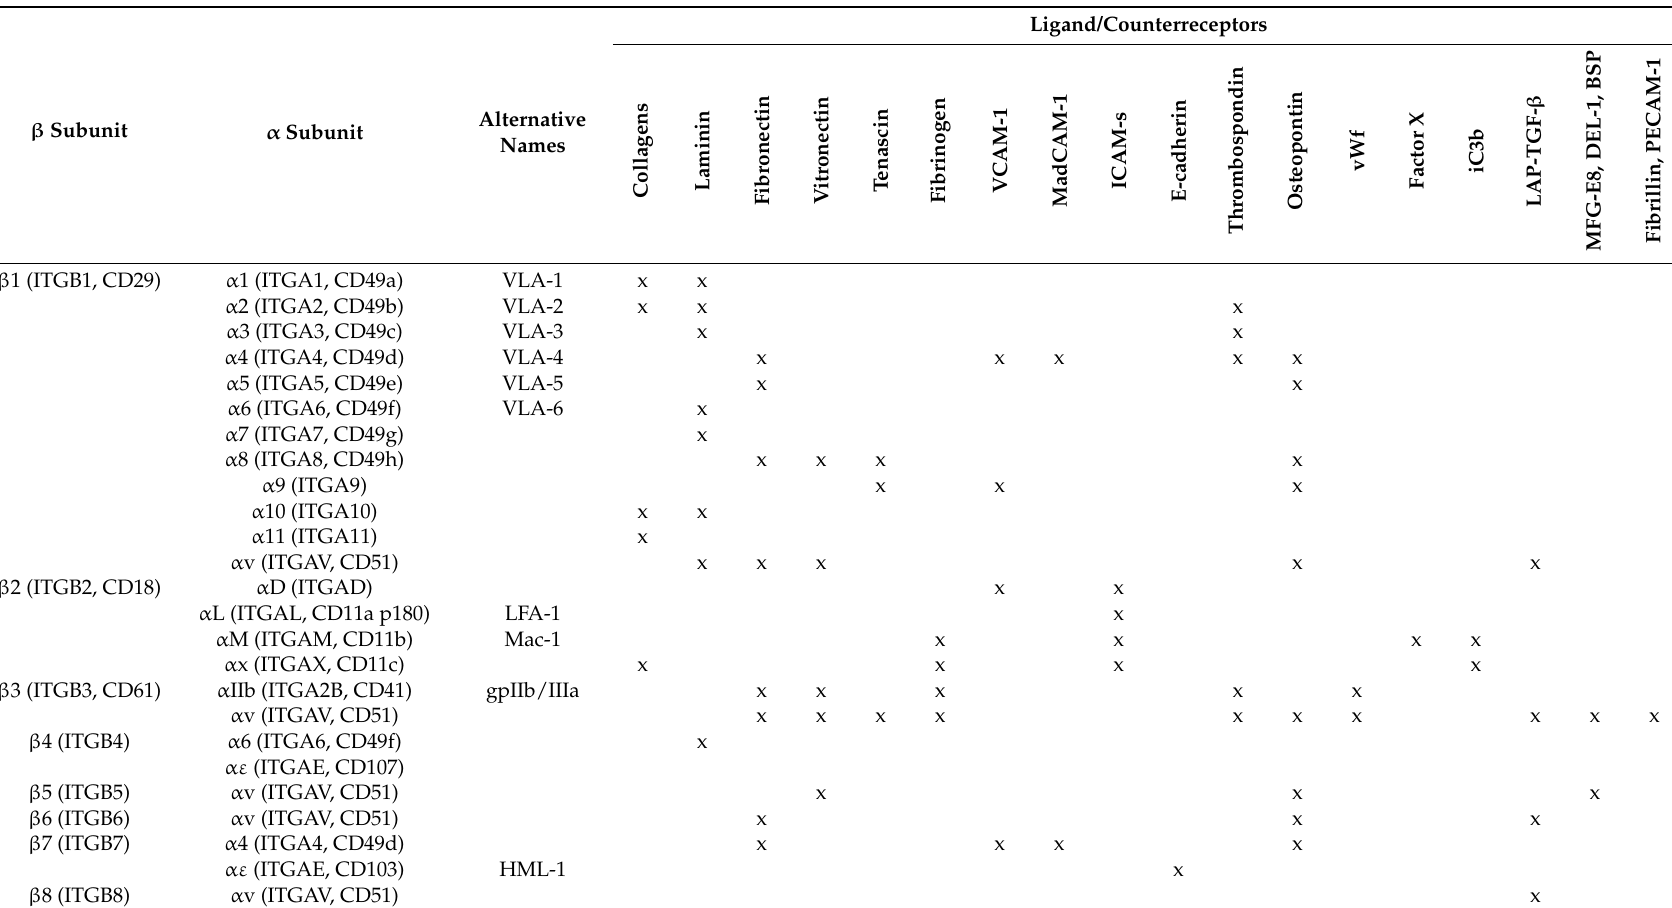
Table 1. Integrin heterodimers and their